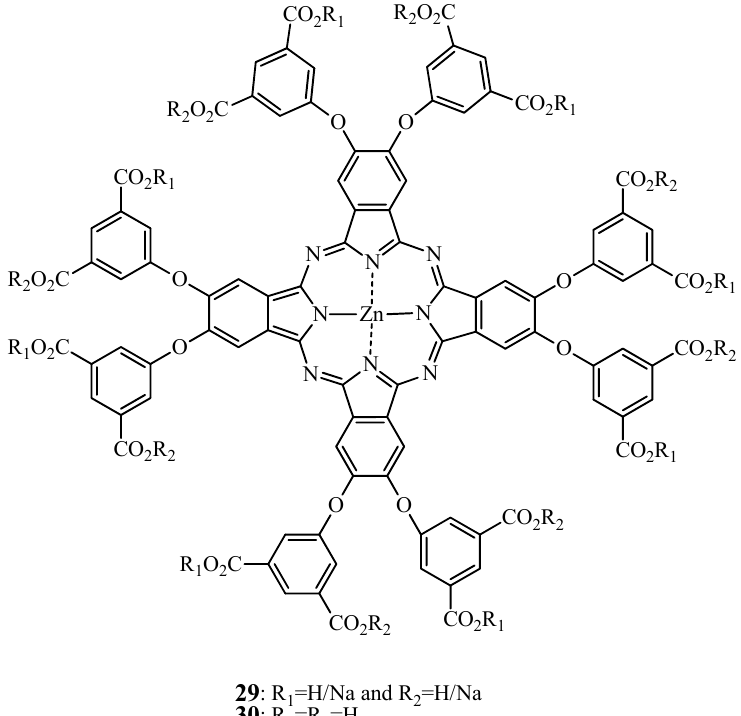
Figure 12. Chemical structure of phthalocyanines 29 and 30 .